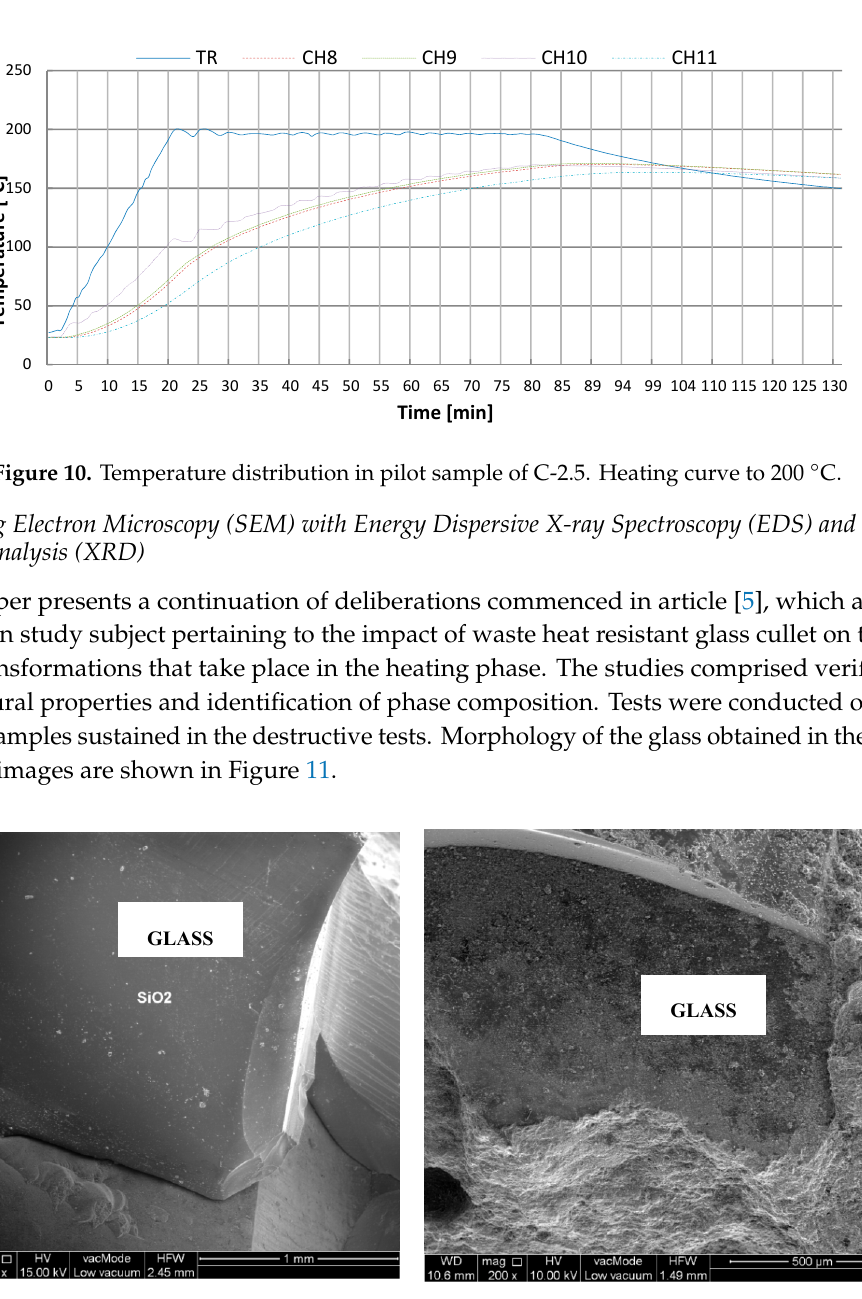
Figure 9. Cubic sample: ( a ) distribution of thermoelements; ( b ) sample with thermocouples. An increase in temperature weakens the structure of the material. Cracking is visible on the sample surface. The actual distribution of temperatures shown in Figure 10 enables observations of